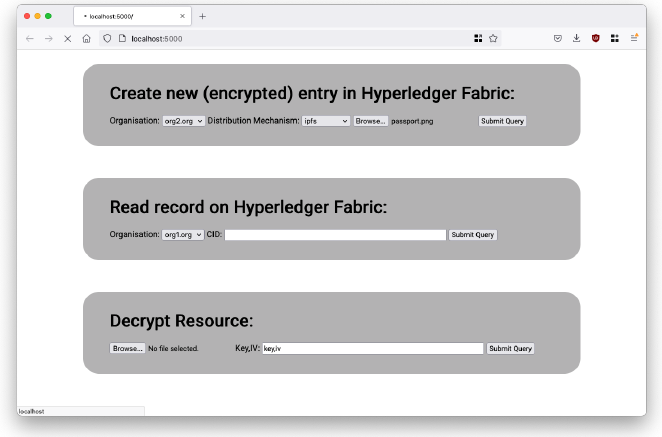
Figure 7. Front-end view of GLASS portal associated with three distinct